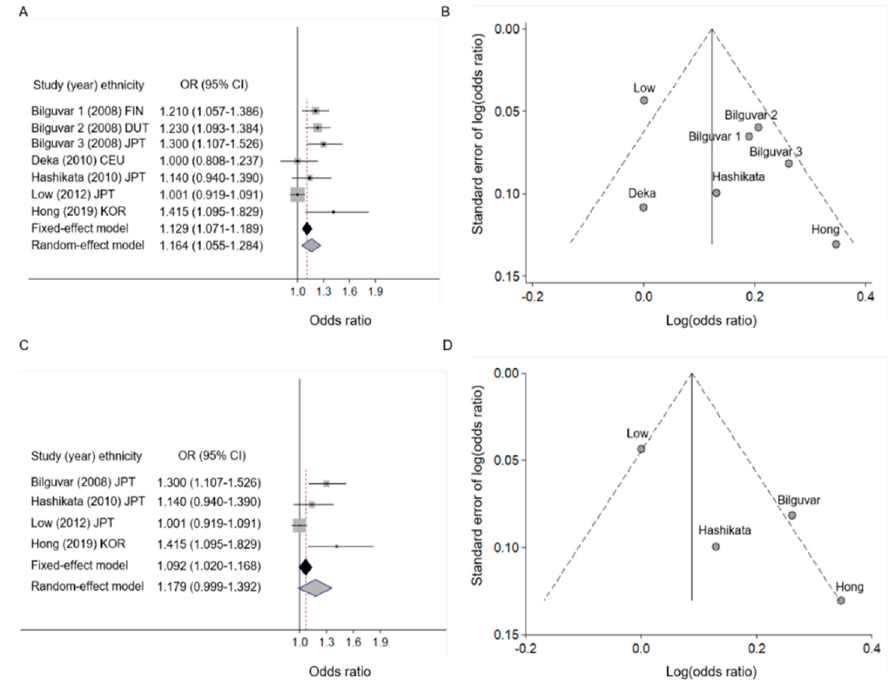
Figure 2. Forest ( A , C ) and funnel ( B , D ) plots for rs700651 in multi-ethnic meta-analysis and subgroup meta-analysis of East Asians using an inverse-variance model. The first author is indicated in panels ( A – D ). The study by Bilguvar et al. 1–3 (2008) [20] contained three genome-wide association studies, including Finnish (FIN), Dutch (DUT), and Japanese (JPT) populations. The study by Deka et al. (2010) [21] included 406 sporadic Caucasian (CEU) patients and 392 healthy controls enrolled from 26 multi-centers. The horizontal line indicates the 95% confidence interval, the shaded square box indicates the weight of each study, and the black spot in the center of the square box indicates the odds ratio of each study. The pooled odds ratio estimates from the fixed-e ff ect (black diamond) or random-e ff ect (grey diamond) inverse-variance models are shown in panels ( A ) and ( C ). The X- and Y-axes in panels ( B ) and ( D ) indicate the pooled log-transformed odds ratio “Log (odds ratio)” and the standard error, respectively.